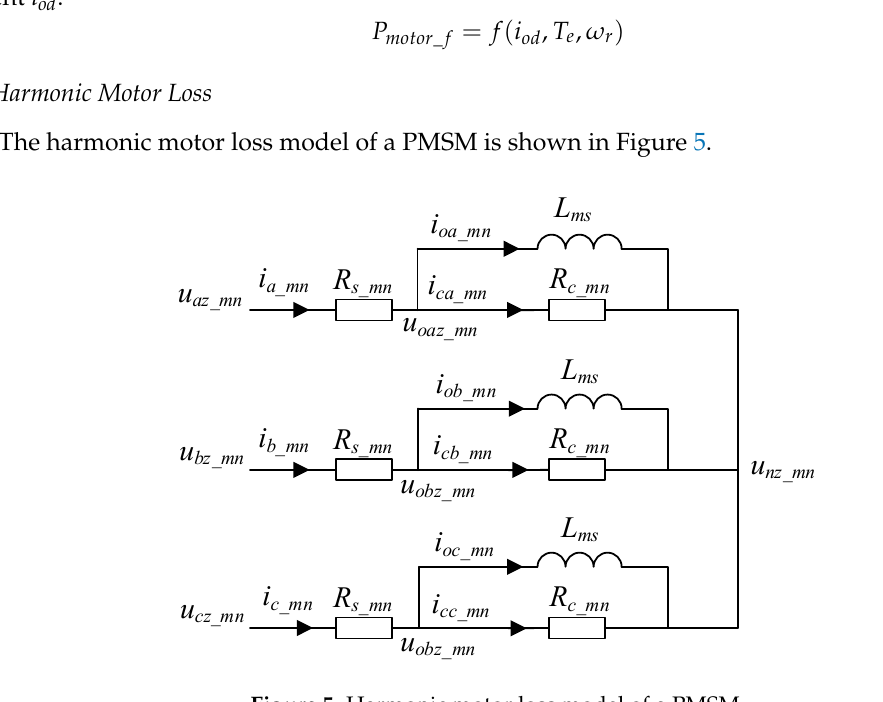
Figure 5. Harmonic motor loss model of a PMSM.